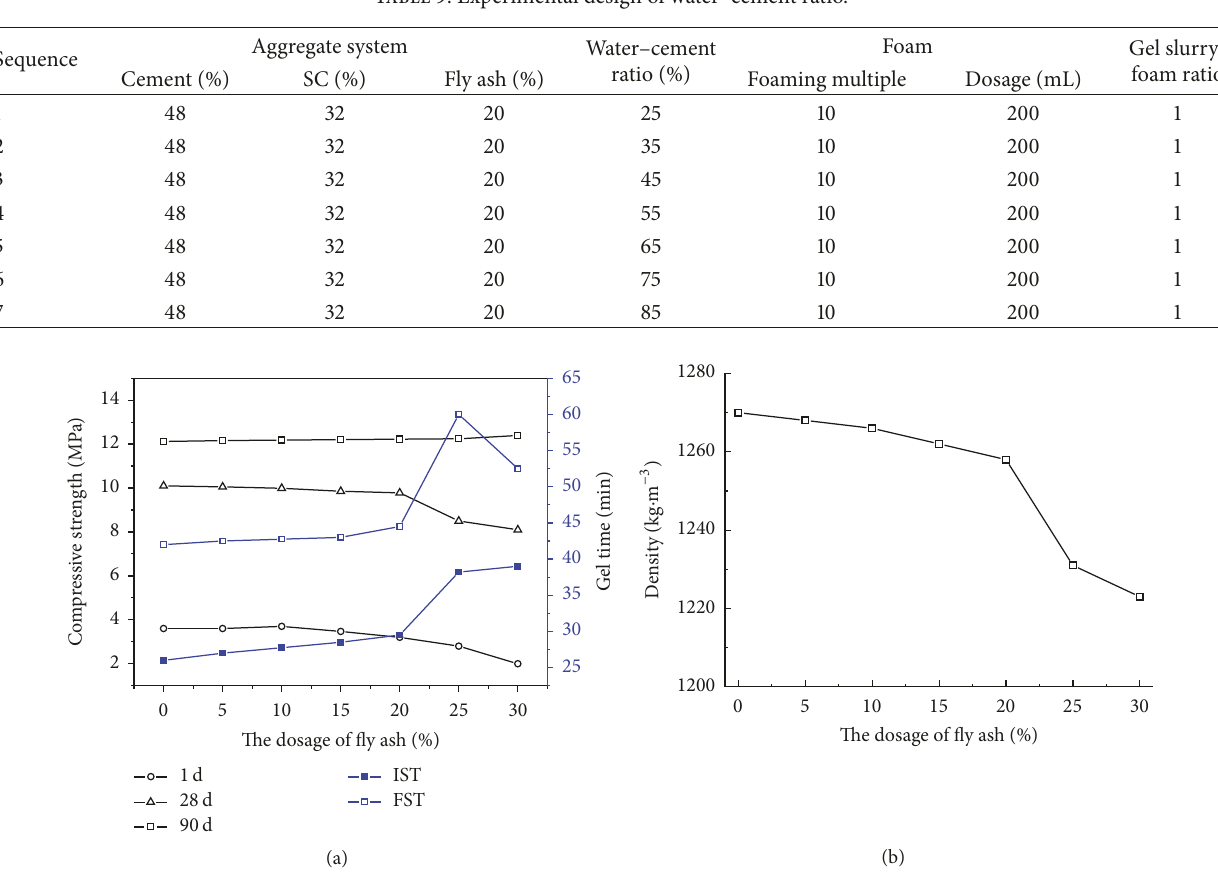
Table 9: Experimental design of water–cement ratio.